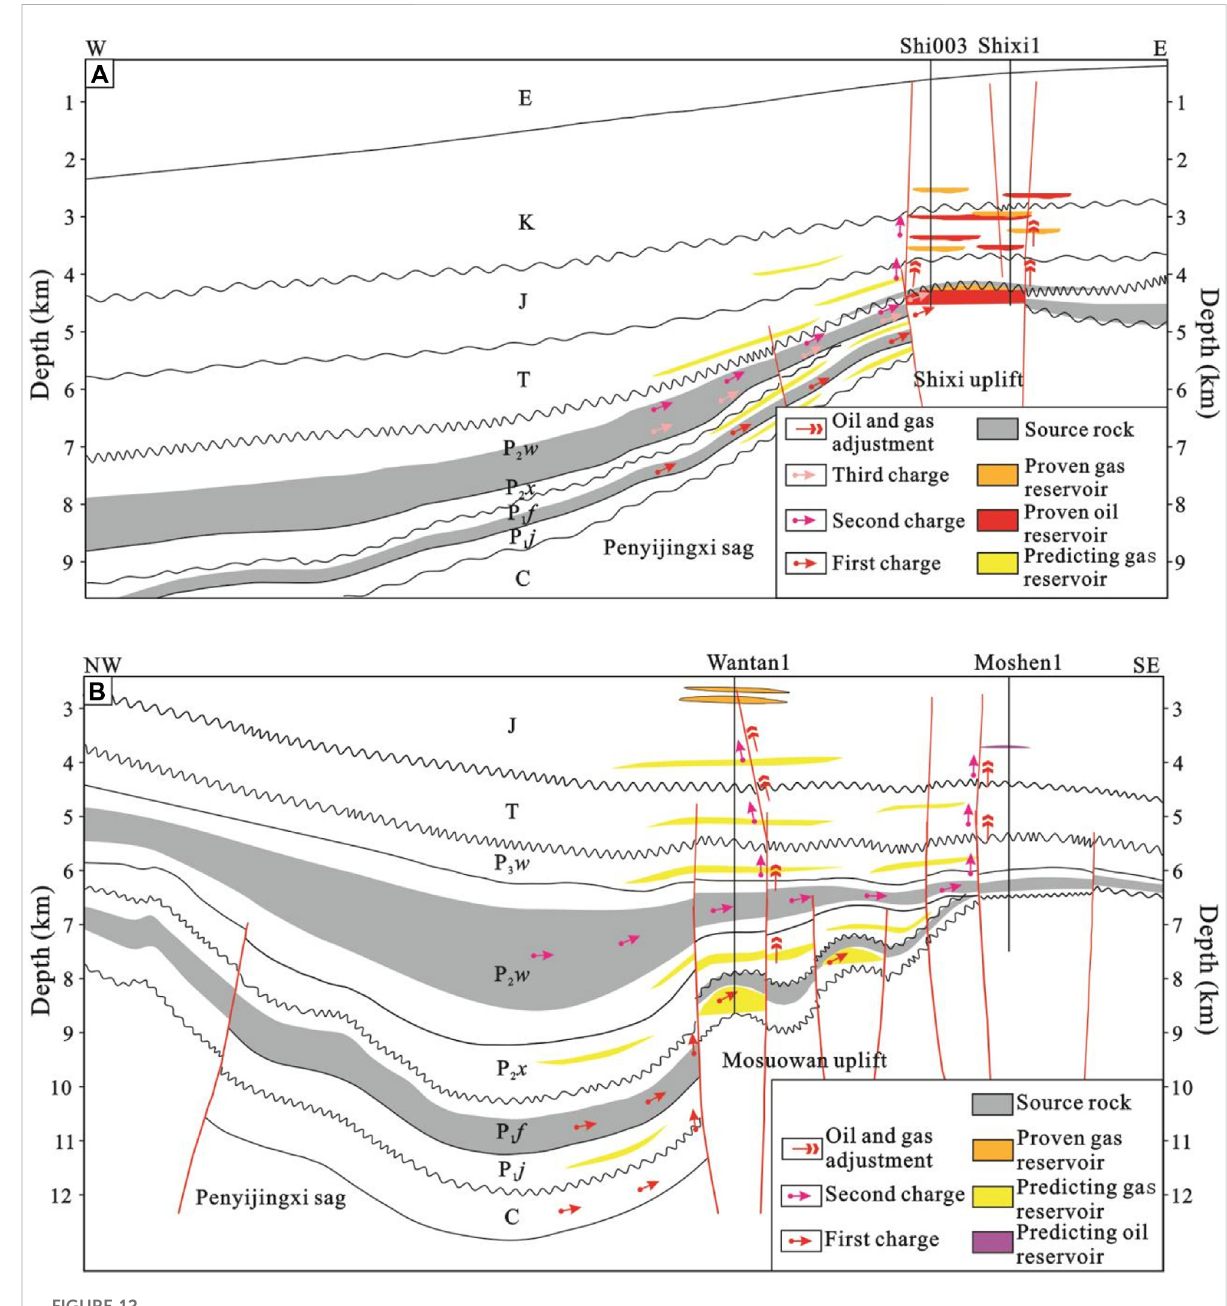
FIGURE 12 Patterns of oil – gas accumulation in deep Carboniferous reservoirs of the Junggar Basin. (A) Shixi Uplift; (B) Mosuowan Uplift. See Figure 1 for